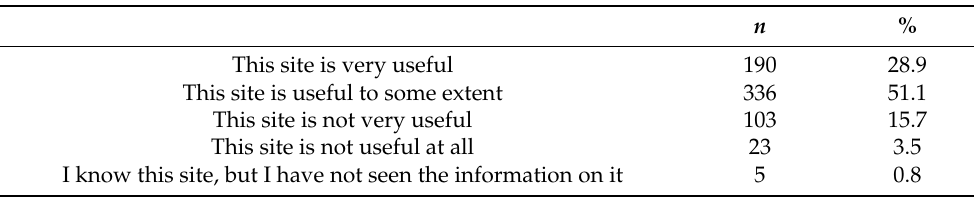
Table 11. The usefulness of “Information for Consumers Related to COVID-19” published by the NIBIOHN for users.